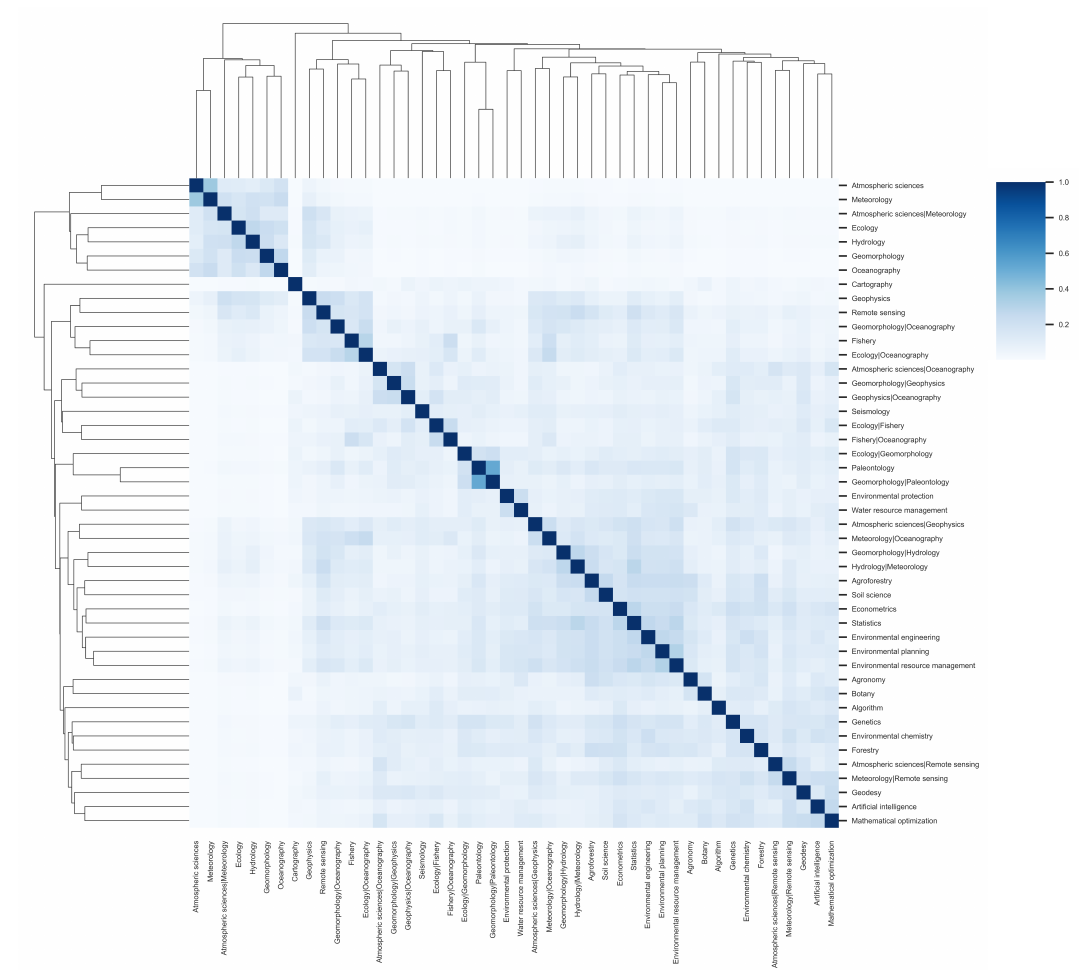
Figure 4. Organisational cluster map in the realm of climatology, showing how similar the disciplines are according to their networks of